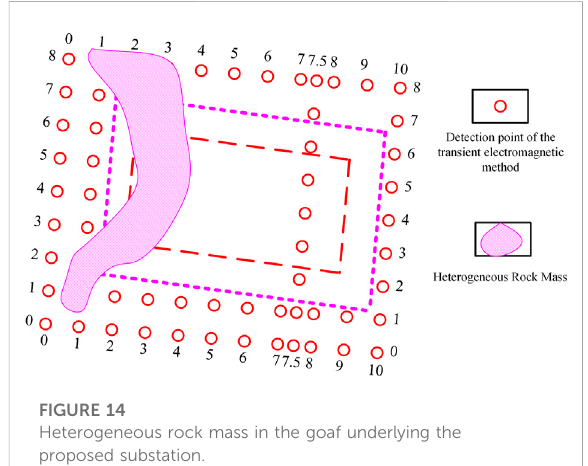
FIGURE 14 Heterogeneous rock mass in the goaf underlying the proposed